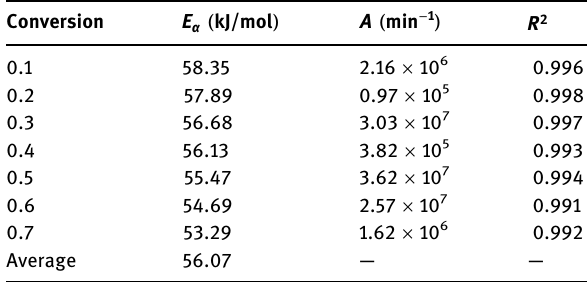
Table 4: Combustion kinetic parameters of sample K1